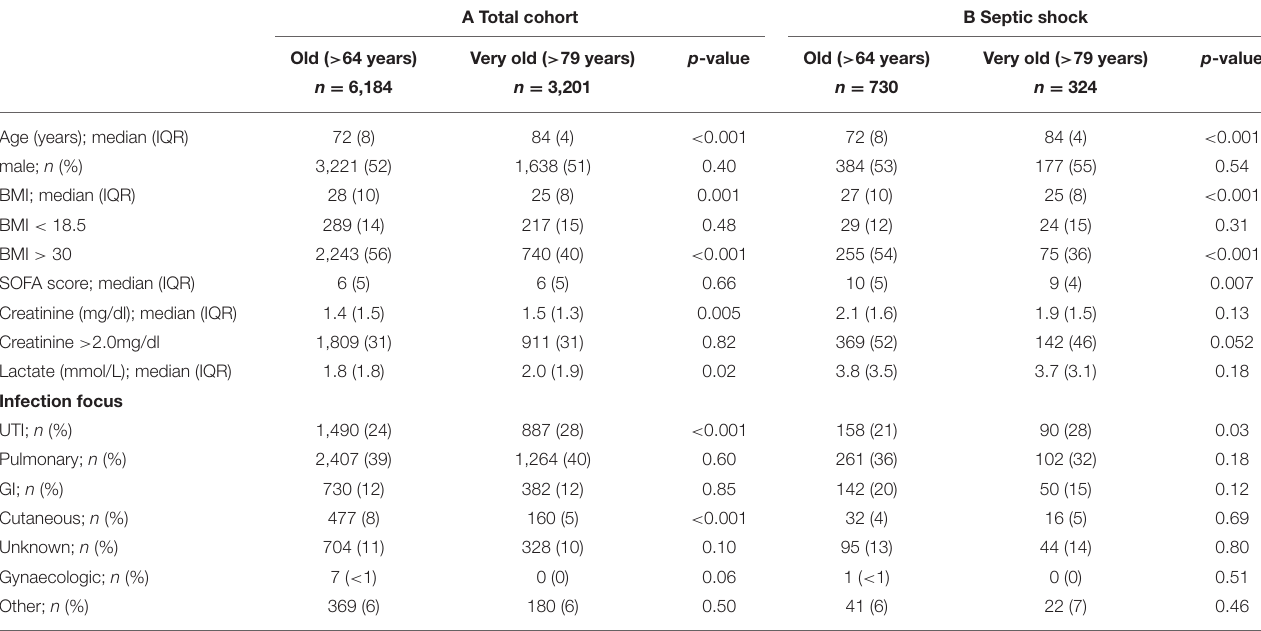
TABLE 1 | Baseline characteristics in the total cohort (A) and the subgroup of patients with septic shock (B) stratified for age categories into old and very old septic